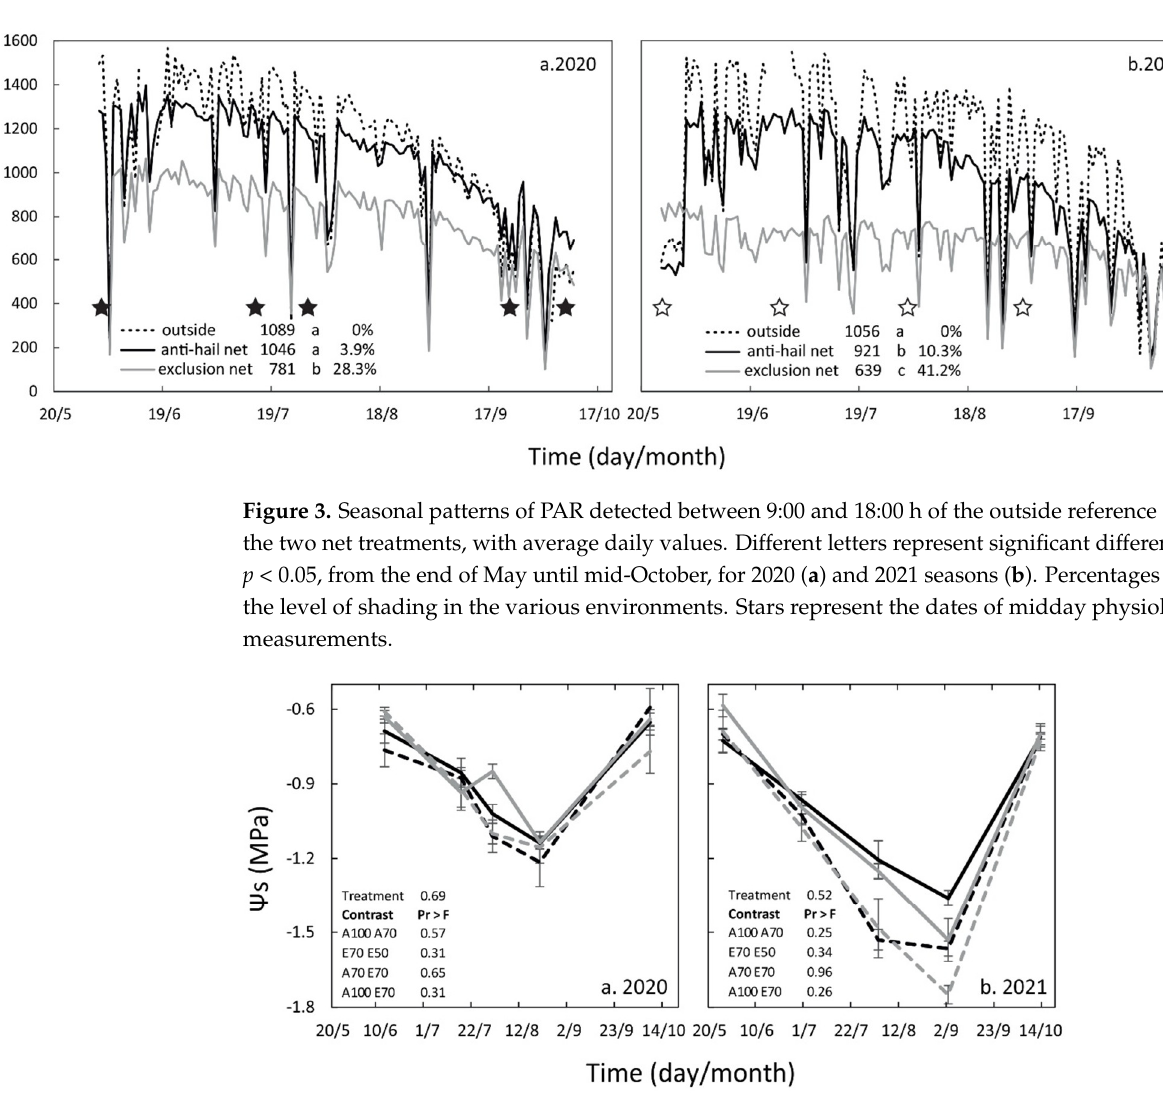
Figure 4. Seasonal patterns of midday stem water potential throughout 2020 ( a ) and 2021 ( b ), for each treatment, represented by the mean value of four trees. Vertical bars represent standard error values. For each year, the effect of the treatment and linear contrast F values are shown and refer to the mean midday seasonal value of Ψ s ; values below 0.05 are considered significant.